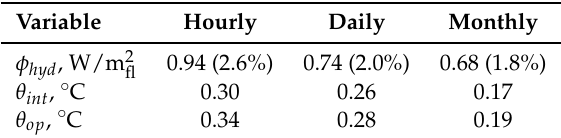
Table 6. Root mean square deviation (RMSD) for hourly, daily, and monthly averages on energy use ( φ hyd ) and internal air ( θ int ) and operative temperatures ( θ op ) variables. For φ hyd , CV(RMSD) is shown within parenthesis.